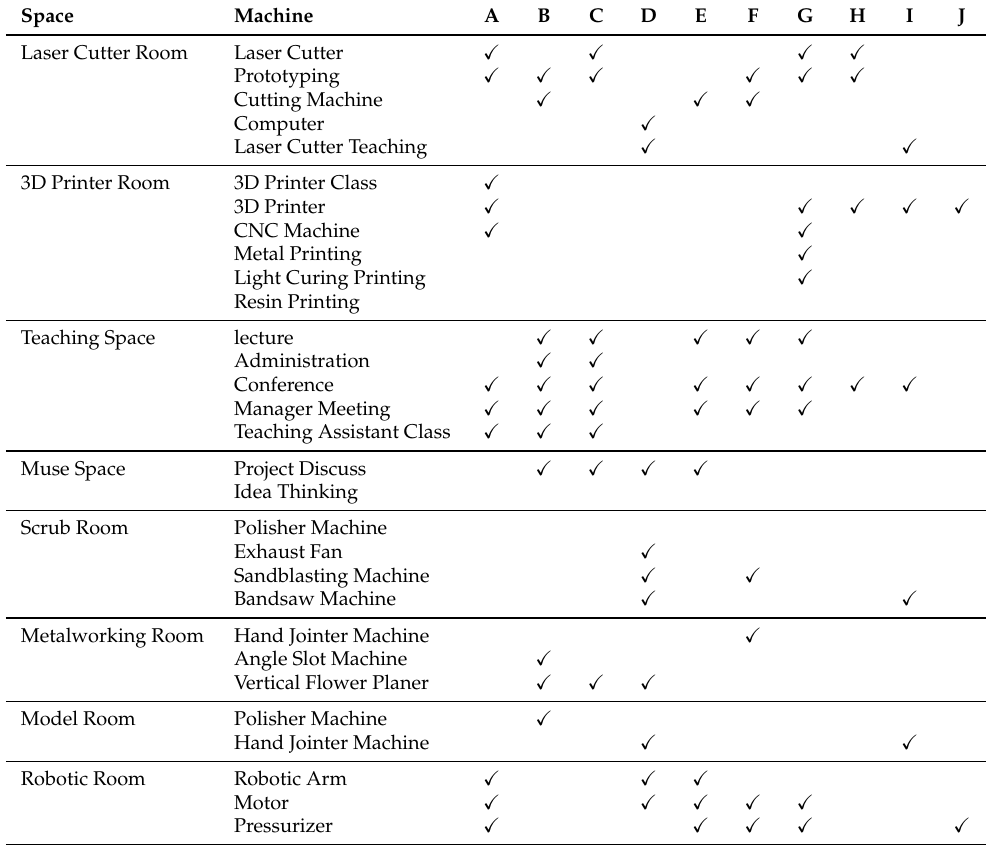
Table 1. Co-fabrication space